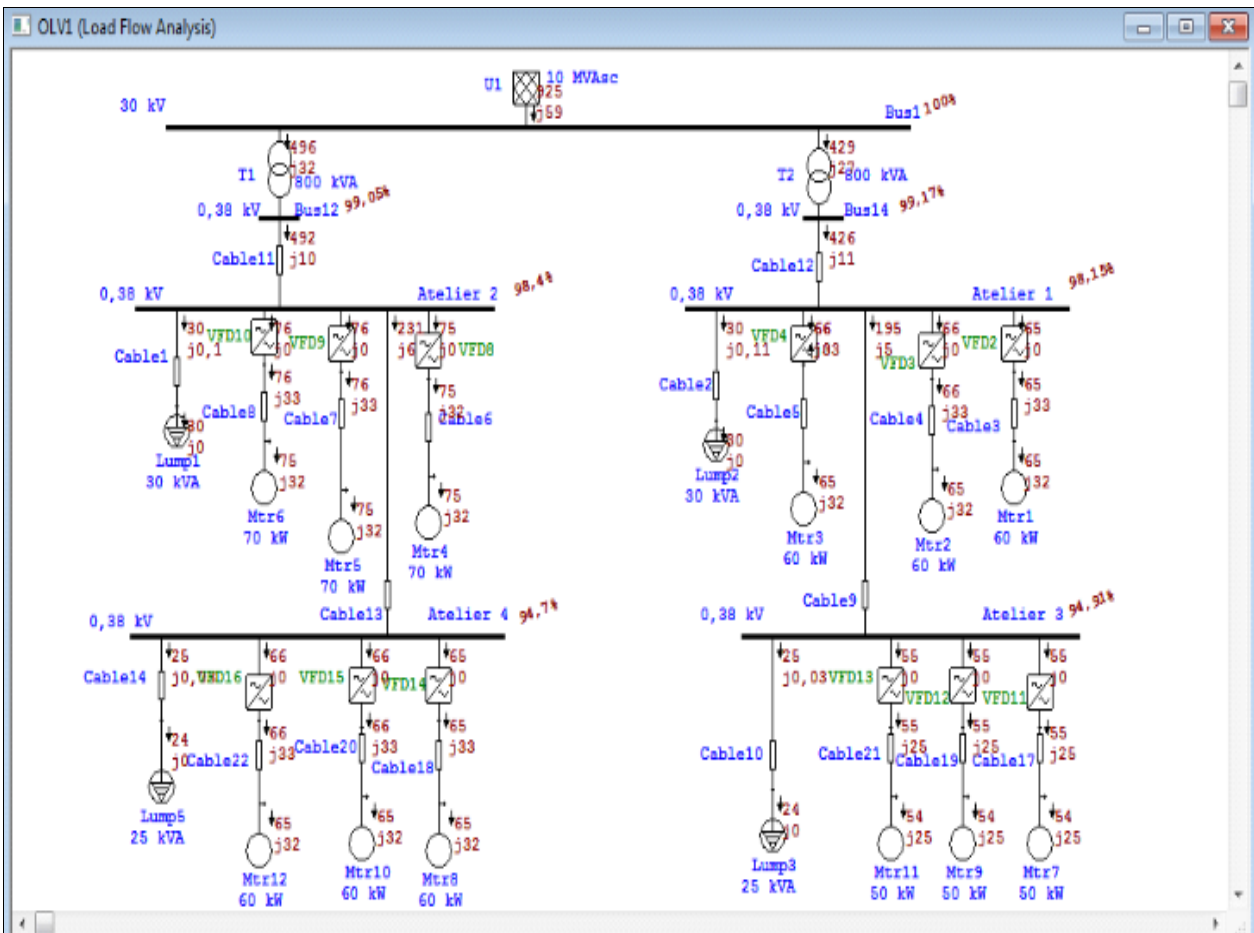
Figure 12: The power flow after insertion of